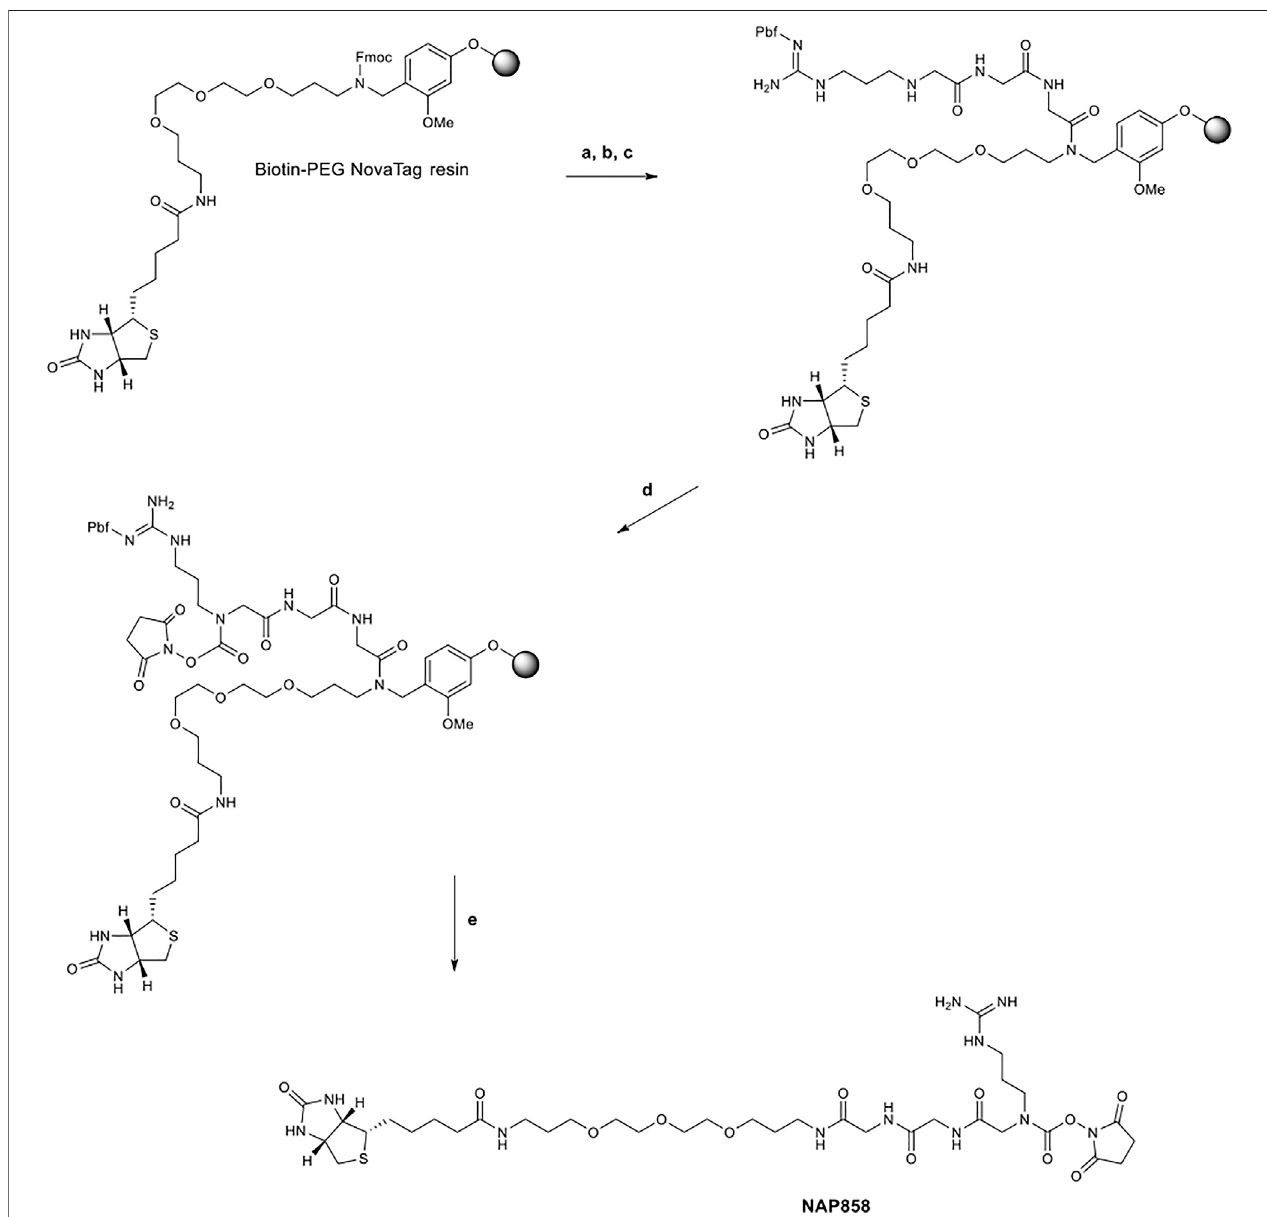
FIGURE2| SyntheticschemeforthepreparationofNAP858. (A) Piperidine/DMF(1/5,v/v),ii)Fmoc-Gly-OH,DIC,HOBt,DMF,thenrepeati)andii)forasecondGly residue, (B) i) Piperidine/DMF (1/5, v/v), ii) Fmoc-NArg (Pbf)-OH, DIC, HOBt, DMF, (C) Piperidine/DMF (1/5, v/v), (D) N,N ′ -disuccinimidyl carbonate, 2,6-lutidine, anhydrous DCM, (E) TFA/TIPS/DCM (95/2.5/2.5, v/v/v).